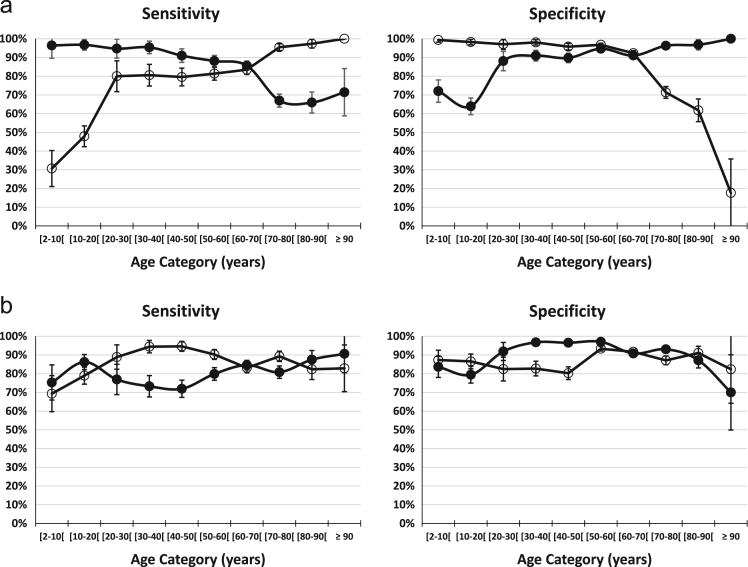
a: Sensitivity and Specificity per age-category. Solid circles correspond to ScysC/QcysC as the test result (positive when > 1.33, negative when ≤ 1.33) and disease status defined by the fixed mGFR threshold of 60 mL/min/1.73 m². Open circles correspond to the reversed situation, that is, mGFR as the test result (positive when mGFR < 60 and negative when mGFR ≥ 60) and disease status defined by the ScysC/QcysC threshold of 1.33. b: Sensitivity and Specificity per age-category. Solid circles correspond to ScysC/QcysC as the test result (positive when > 1.33, negative when ≤ 1.33) and diseases status defined by the age-dependent mGFR threshold COAD. Open circles correspond to the reversed situation, that is, mGFR as the test result (positive when mGFR < COAD and negative when mGFR ≥ COAD) and disease status defined by the ScysC/QcysC threshold of 1.33.